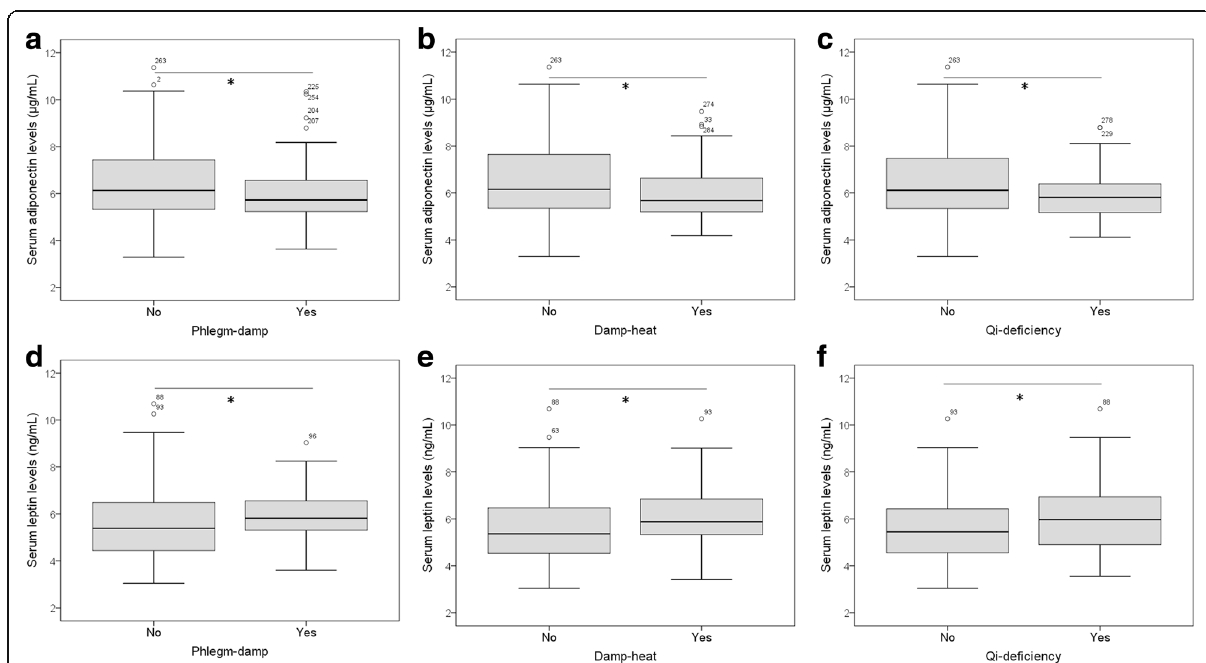
Fig. 3 Serum levels of adiponectin and leptin in IGR subjects with TCM body constitutions. The associations of adiponectin and leptin with Phlegm- damp ( a, d ), Damp-heat ( b, e ) and Qi-deficiency ( c, f ) were investigated. Serum adiponectin levels are significantly lower in IGR subjects with Phlegm- damp, Damp-heat and Qi-deficiency constitutions as compared with IGR subjects without respective constitutions, while serum leptin levels are significantly higher all three TCM constitution types.Wilcoxon-Mann-Whitney test was performed. *P<0.05. IGR: impaired glucose regulation